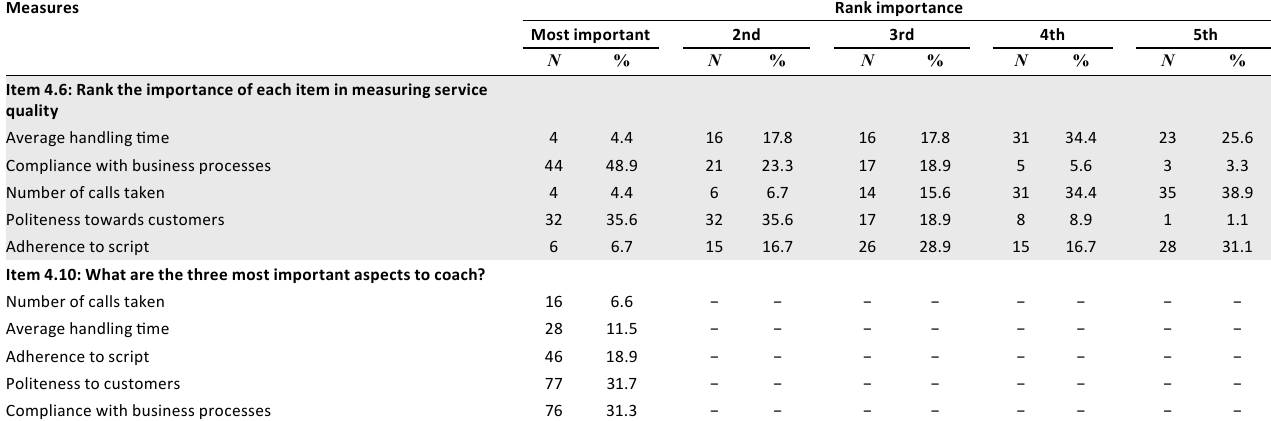
TABLE 4: Measures of service quality and aspects to coach.